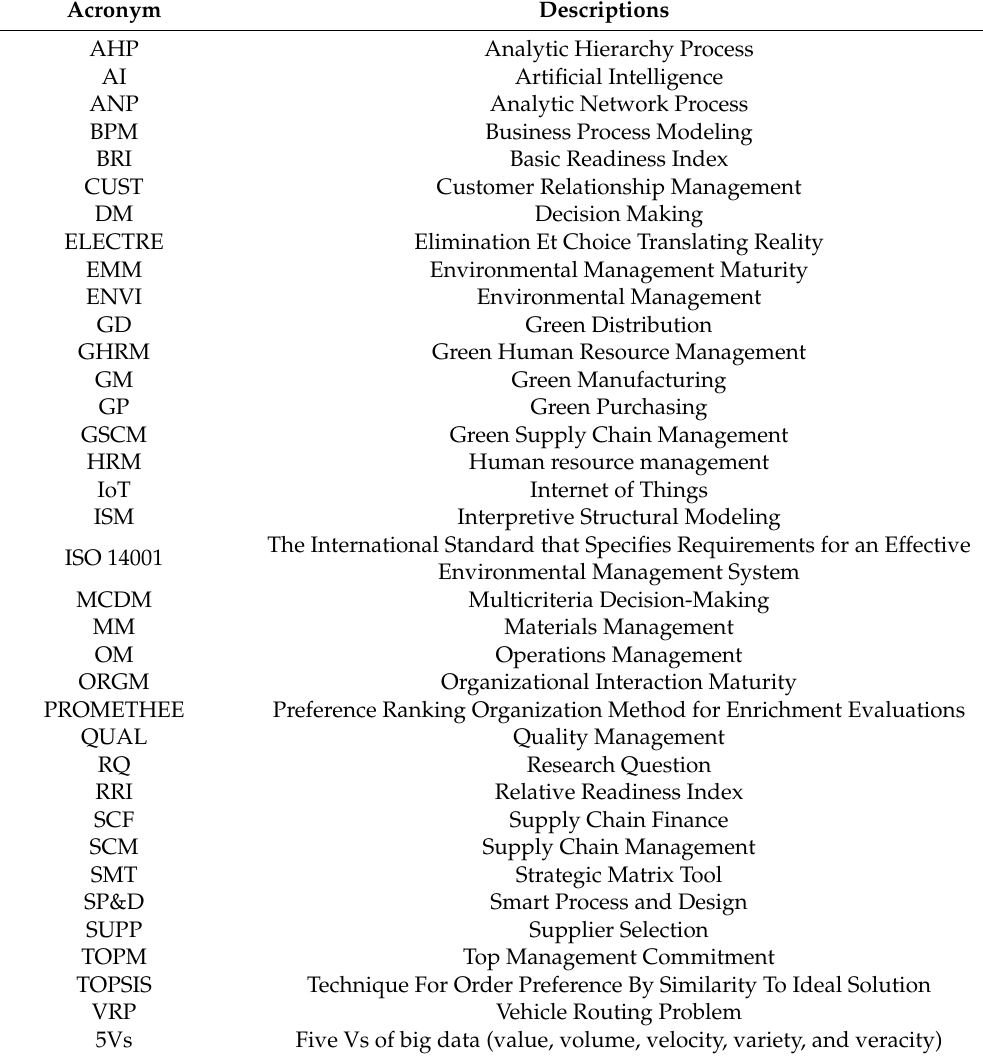
Table 1. List of acronyms and their